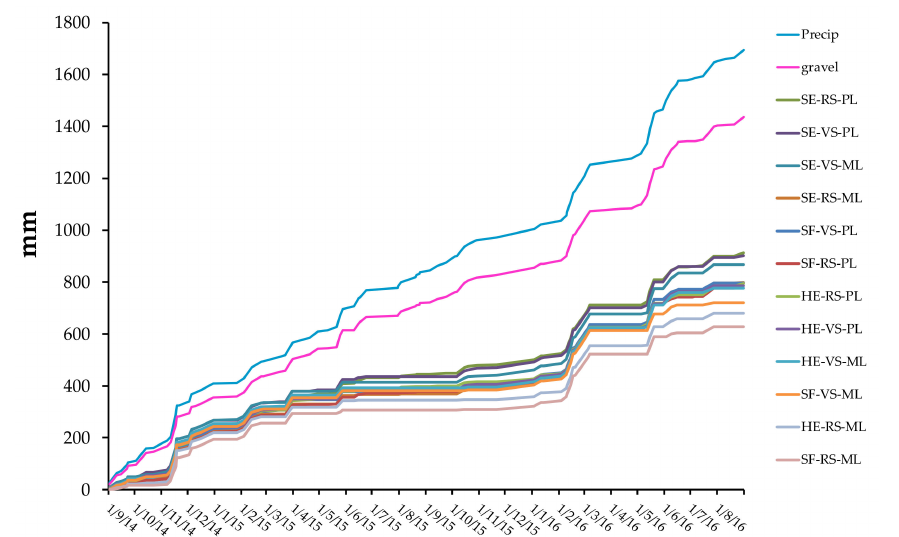
Figure 3. Cumulative outflow from each type of green roof microcosm and comparison with precipitation and gravel. SE = Sedum mix, HP = herbaceous perennial plants, SF = suffruticose, VS = volcanic substrate, RS = recycled crushed bricks substrate, PL = preformed plastic drainage/storage layer, and ML = mineral drainage/storage